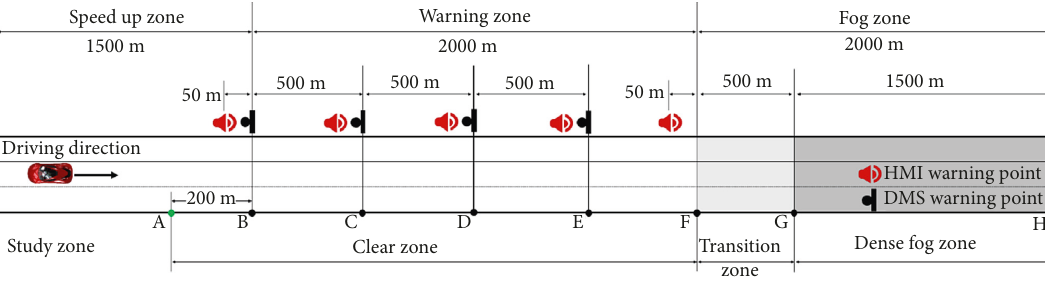
Figure 4: Fog zone scenario.